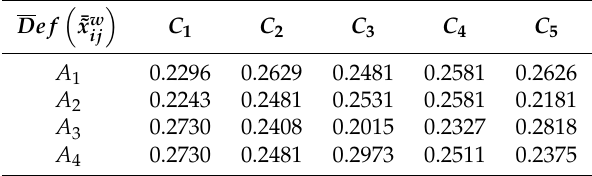
Table 6. The normalized defuzzified weight decision matrix Def ( ¯˜ D )